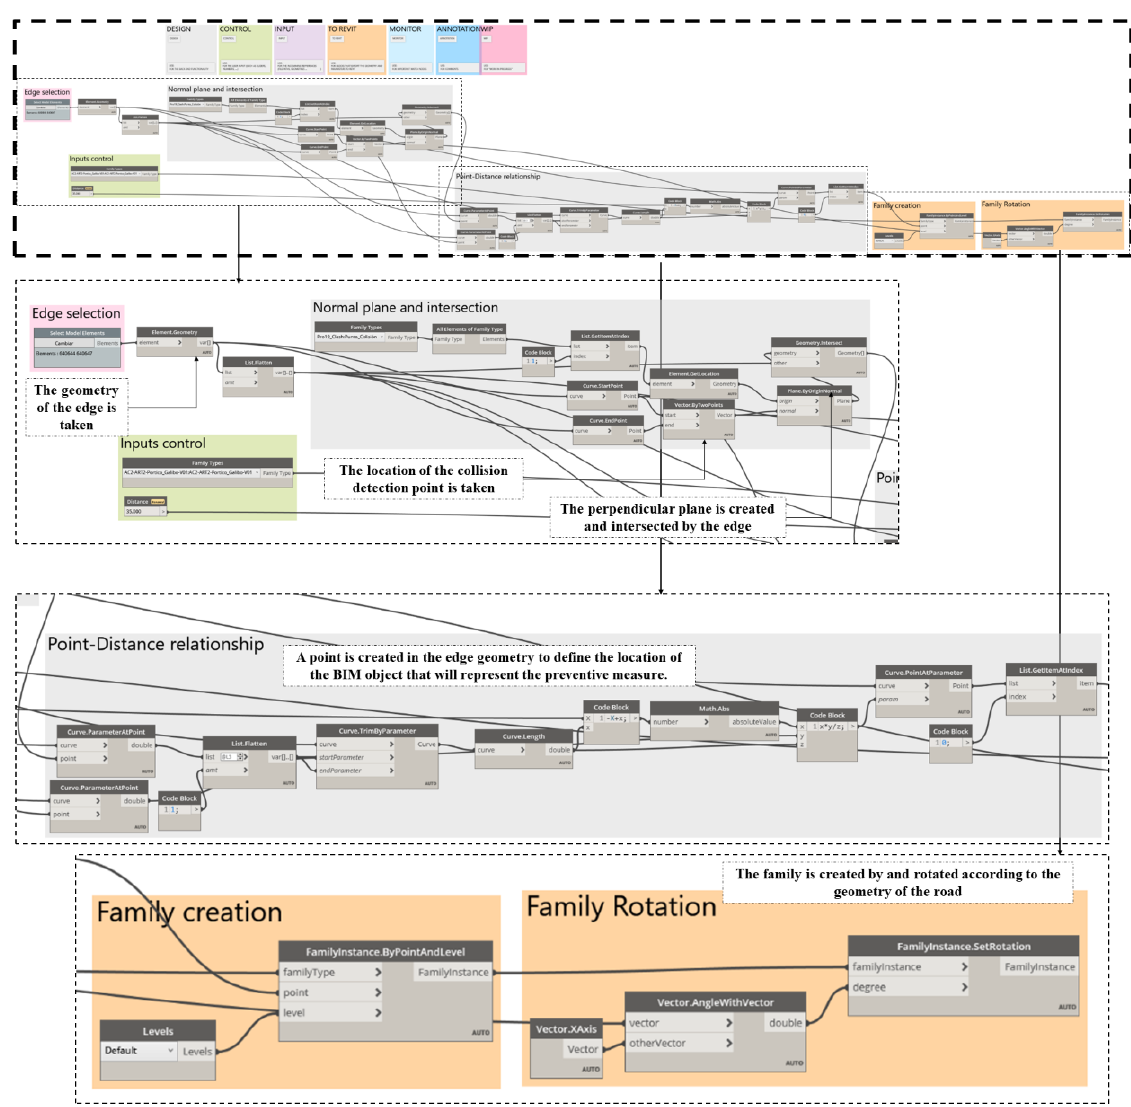
Figure 8. Script for automating the introduction of preventive measures in the model based on the risk assessment and the collision point between the analysis envelope of the machines and the risk zones.